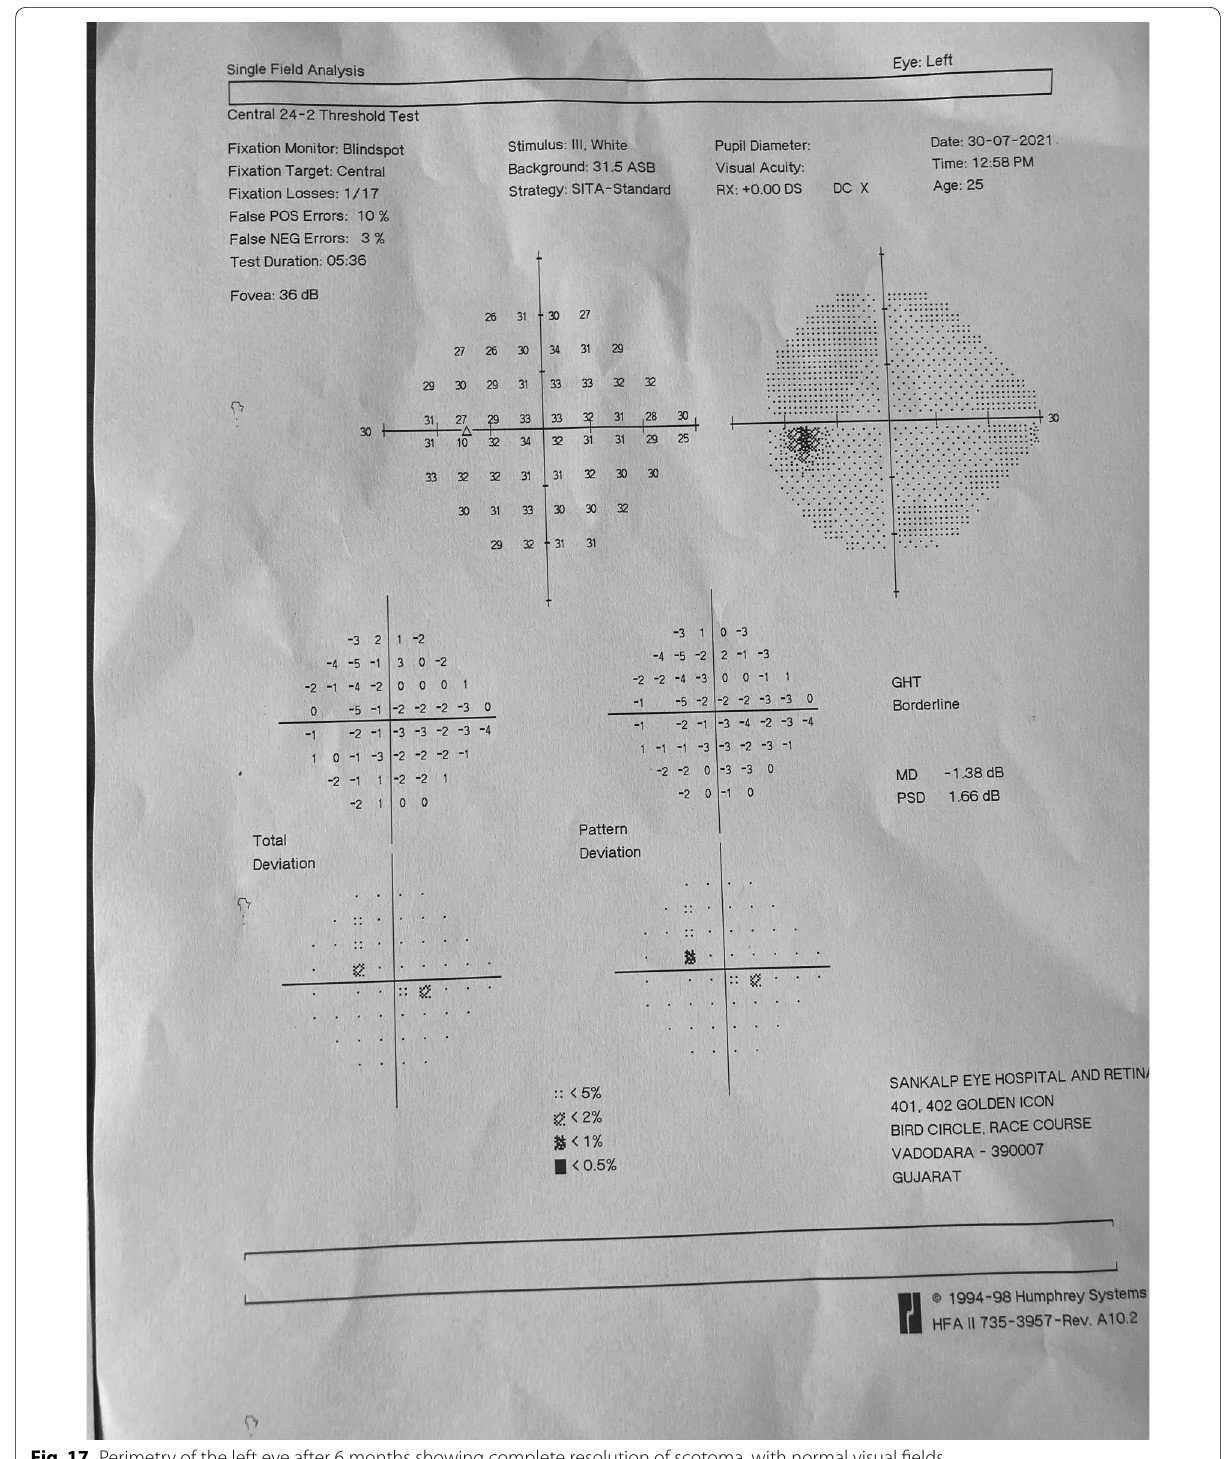
Fig. 17 Perimetry of the left eye after 6 months showing complete resolution of scotoma, with normal visual